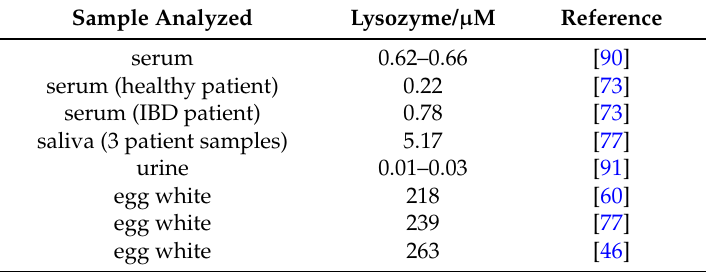
Table 4. Level of lysozyme determined using electrochemical